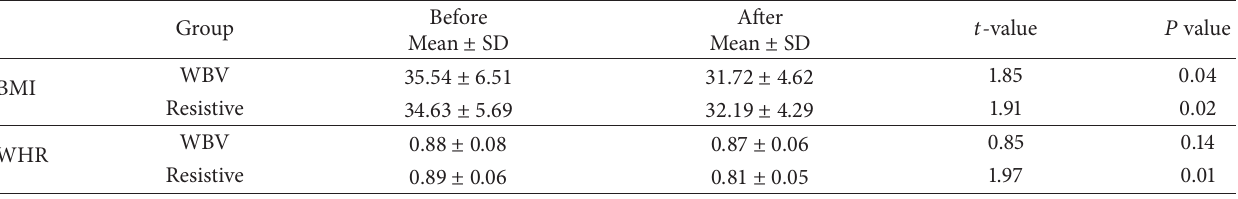
Table 3: Mean and standard deviation of anthropometric measurements for the WBV and resistive exercise groups before and after the study. Before After 𝑡 -value 𝑃 value Group Mean ± SD Mean ± SD WBV 35.54 ± 6.51 31.72 ± 4.62 BMI